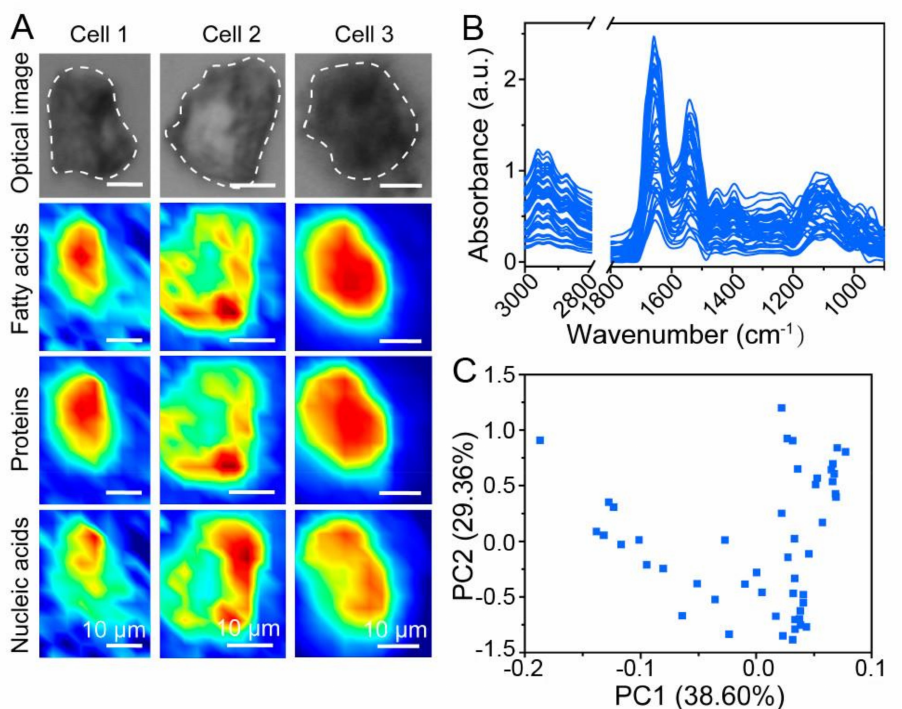
Figure 3. Infrared phenotypic heterogeneity of MSCs during adipogenic differentiation. ( A ) Single- cell optical images and chemical complexity maps of MSCs in the spectral regions associated with fatty acids, proteins, and nucleic acids. (scale bars: 10 µ m) ( B ) Infrared spectra after baseline correction and vector normalization at the wavenumber 3000–800 cm − 1 . ( C ) Score plots of PC1 and PC2 after PCA based on the second-derivative spectra in ( B )